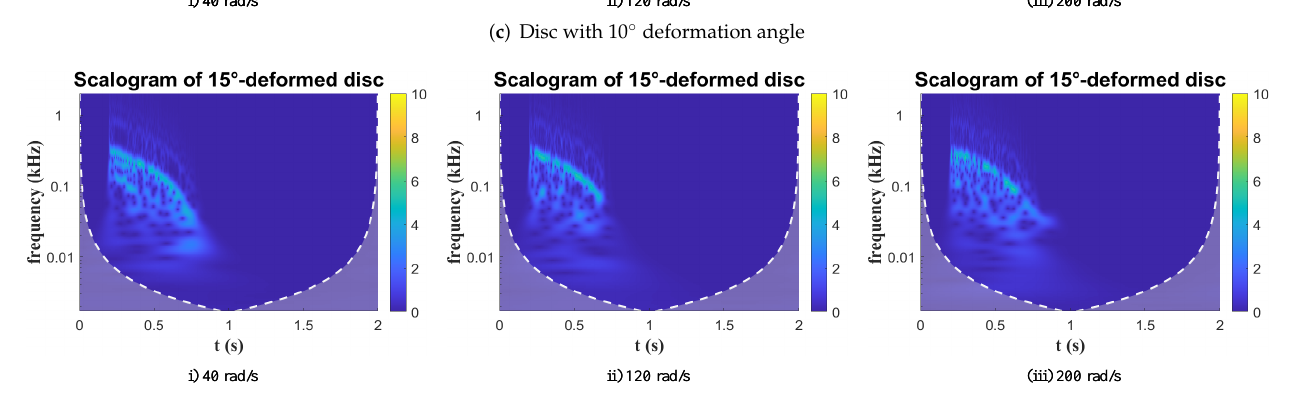
Figure 14. Scalogram: BC = 6 mm, initial force = 5